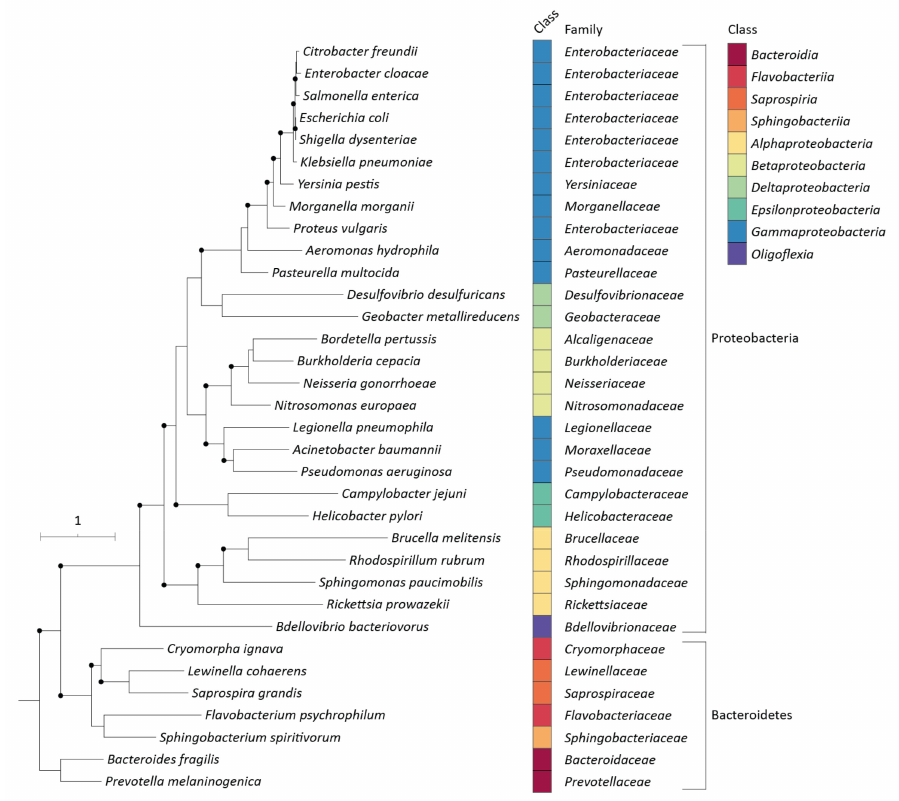
Figure 5. Rooted tree based on the alignment of the LolA protein sequences of the main Gram- negative bacteria. Bootstrap values of >70% (1000 replicates) are illustrated by black, filled circles at the nodes. The scale bar indicates the expected number of substitutions per